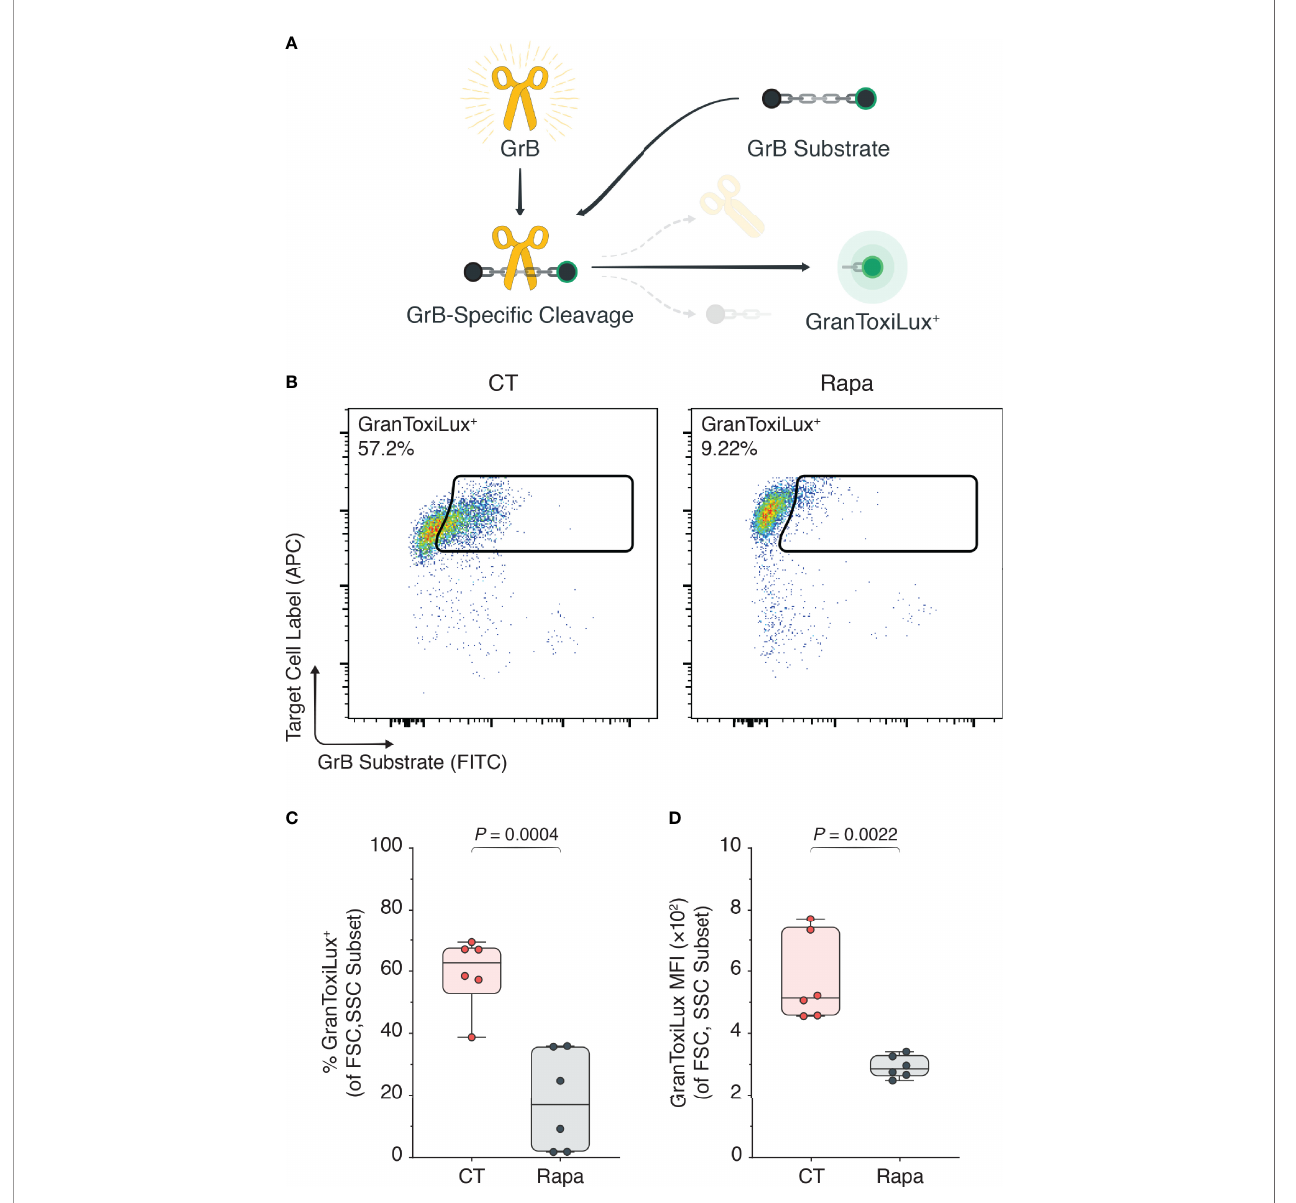
FIGURE 2 | mTORC1 inhibition attenuates intracytoplasmically active GrB. Human T regs were isolated and expanded for three days with a -CD3, a -CD28, and IL-2 (CT), or with CT stimulants plus 100 nM rapamycin (Rapa). (A) The GranToxiLux assay was used to determine functionally active GrB in the cytoplasmic T reg compartment, where active GrB cleaves the GrB-sensitive GranToxiLux substrate to yield a fl uorescent GranToxiLux reagent detectable in the FITC channel. (B) Flow cytometric plots of active GrB in the T reg cytoplasm. (C, D) Box plots of GranToxiLux + percentages (C) and mean fl uorescence intensities (D) among the T reg population (n = 3 technical replicates/condition; 2 representative experiments of 4). Data represent boxplots with median, interquartile range, minimum, maximum, and all individual data points of the denoted experimental groups. P values were calculated with independent samples two-tailed Student ’ s t -tests, and non-parametric Mann-Whitney U -tests